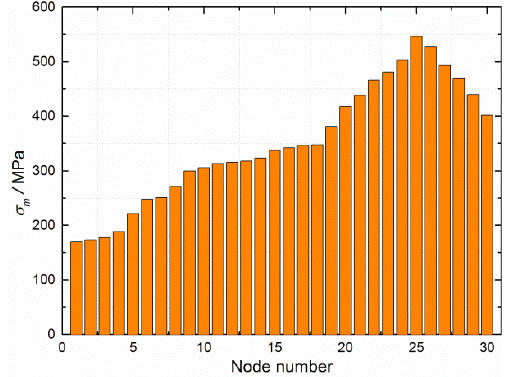
Figure 11. The values of the contact stress distributed in the contact interface. Table 4. The sealing performance indices and structure parameters of the initial and optimized versions.